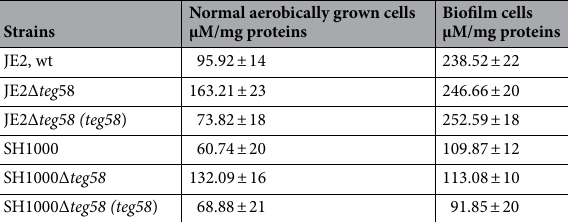
Table 2. Estimation l-citrulline in various S. aureus